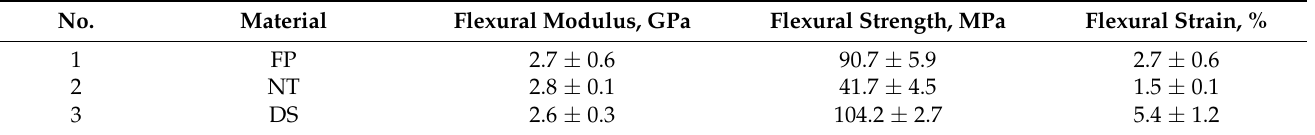
Table 2. The mechanical properties of the 3D printed PMMA of the studied grades.